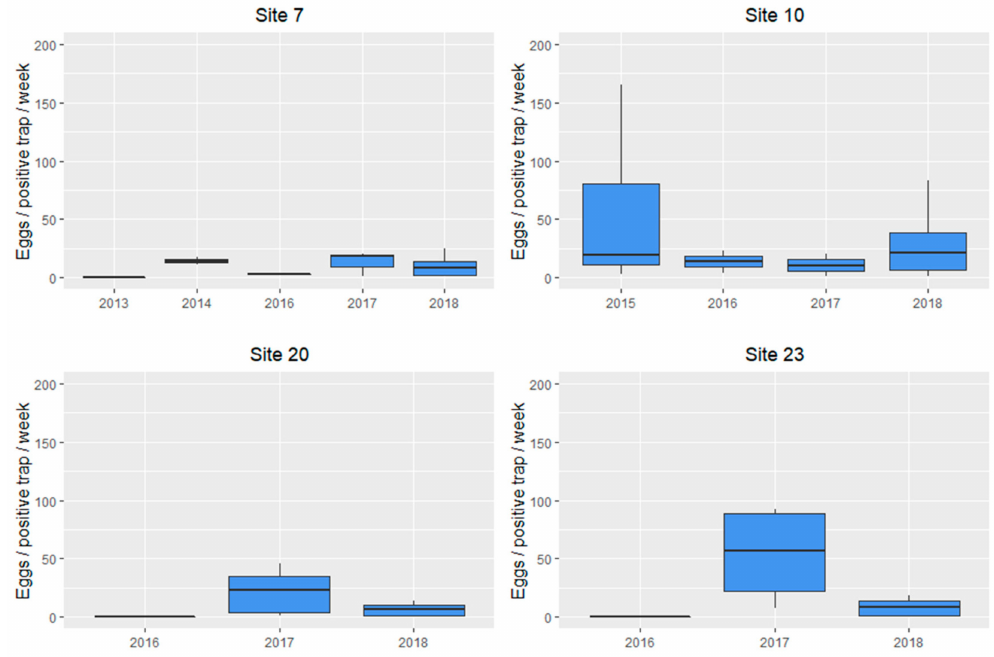
Figure 3. Boxplot showing the number of eggs per positive ovitrap over the years in the 4 sampling sites where Ae.albopictus eggs were observed during consecutive years: Boxplot graphs represent the median burden, the lower and upper quartiles (boxes), and minimum and maximum values